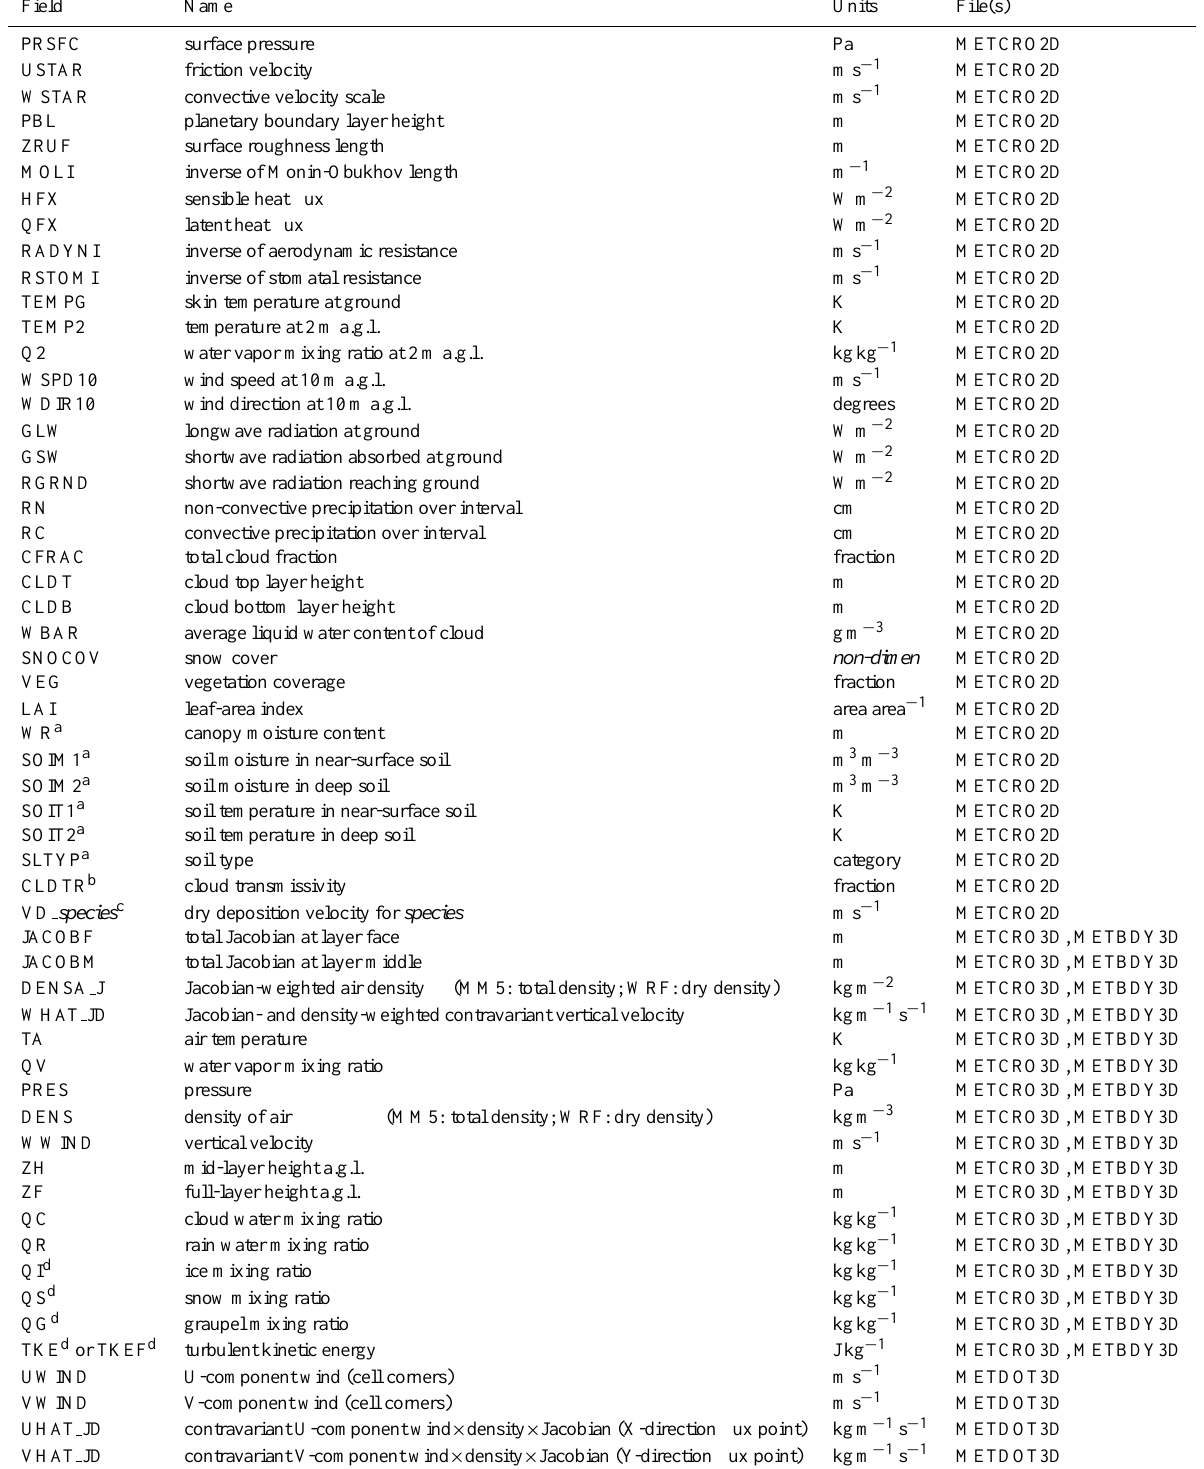
Table 4. Time-varying fields that are output by